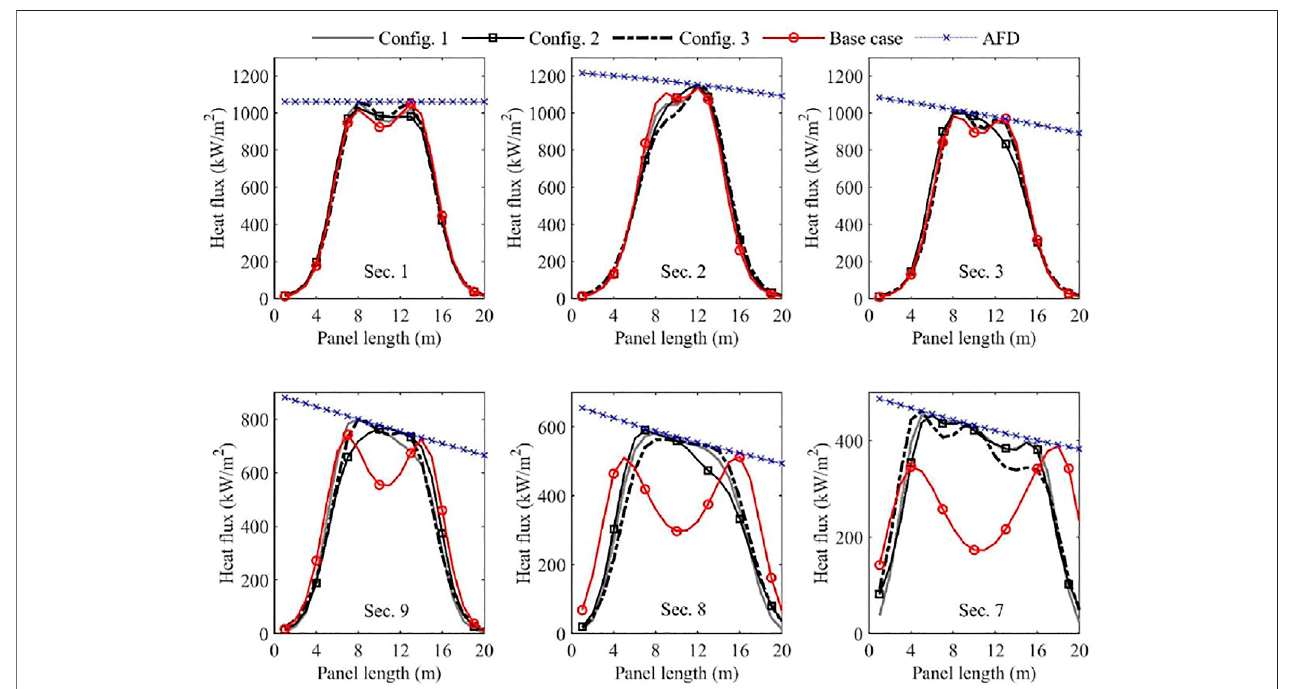
FIGURE 7 | Heat fl ux distribution for each con fi guration and its comparison with the base case for fl ow path 1.